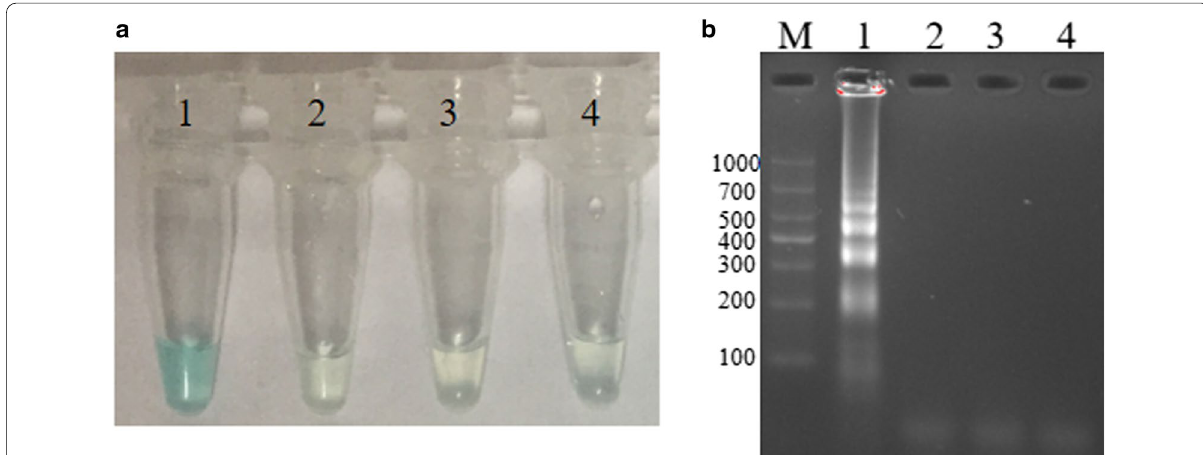
Fig. 3 Confirmation of S. agalactiae -MCDA products. Methods of Malachite Green ( a ) and 2% Agarose gel electrophoresis ( b ) were used to